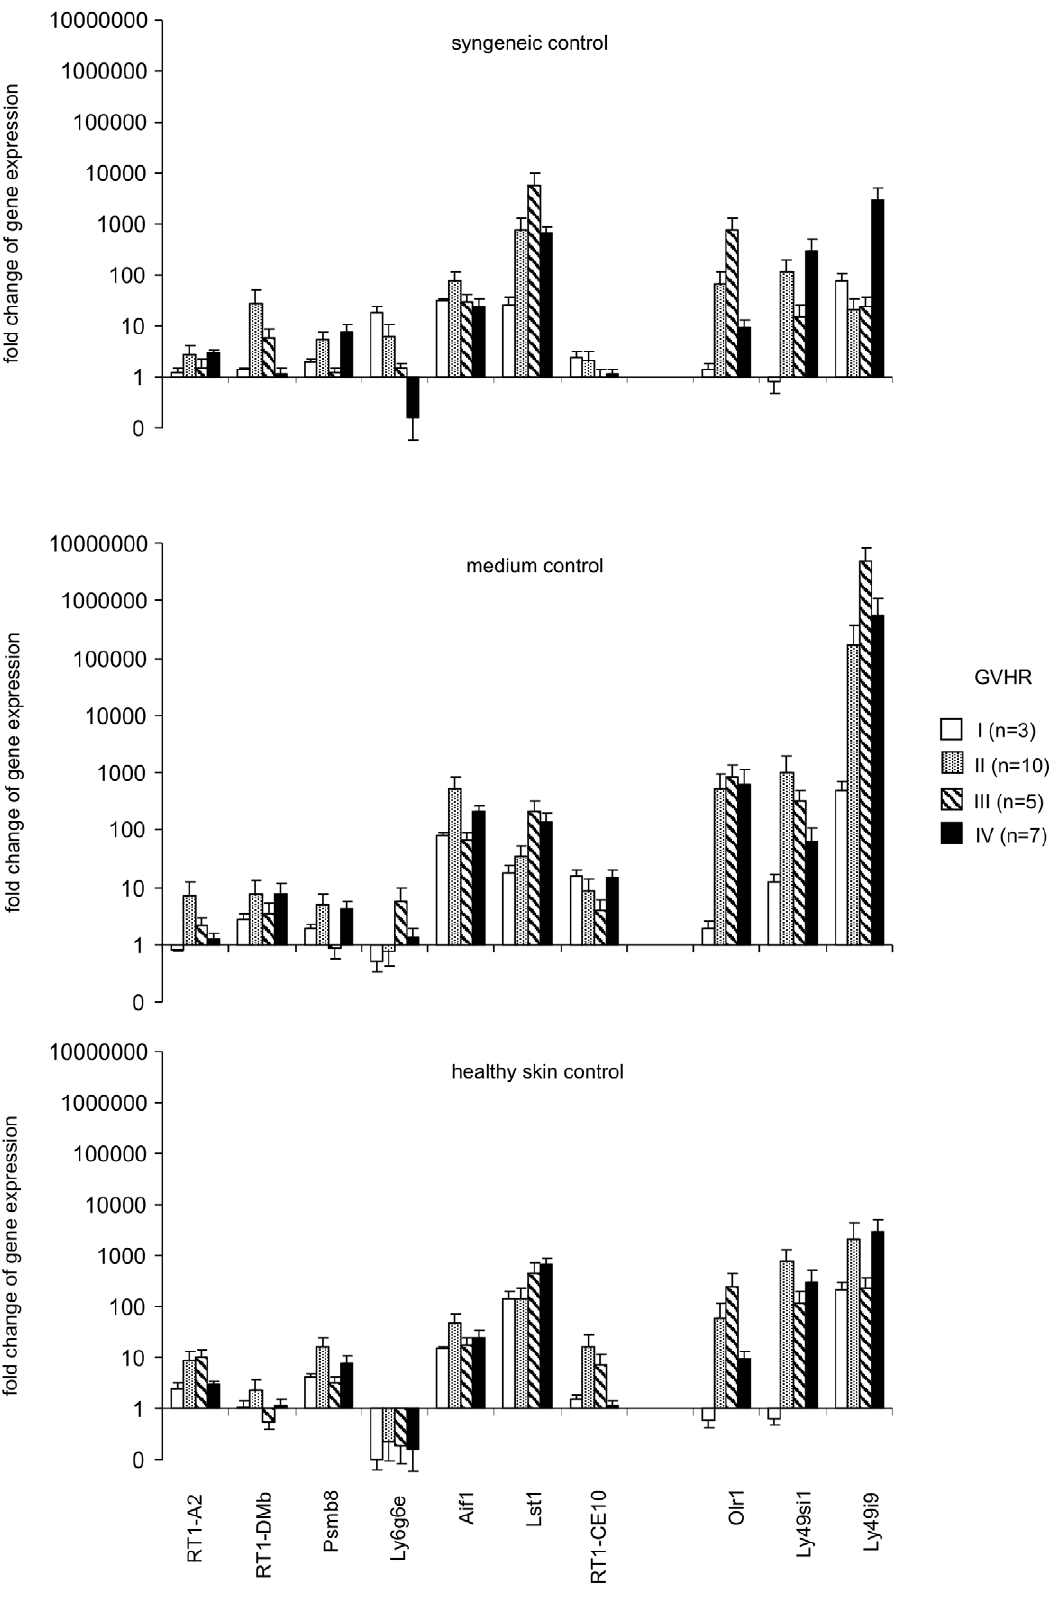
Figure 7. Analysis of MHC and NKC gene regulation in skin explants exposed to pre-stimulated allogeneic lymphocytes depending on GVHR grading. The expression of 7 MHC and 3 NKC was analyzed by qRT-PCR. The relative changes of gene expression levels were calculated using a mathematical model for relative quantification of real-time PCR data which also takes into account variations of the amplification efficiencies